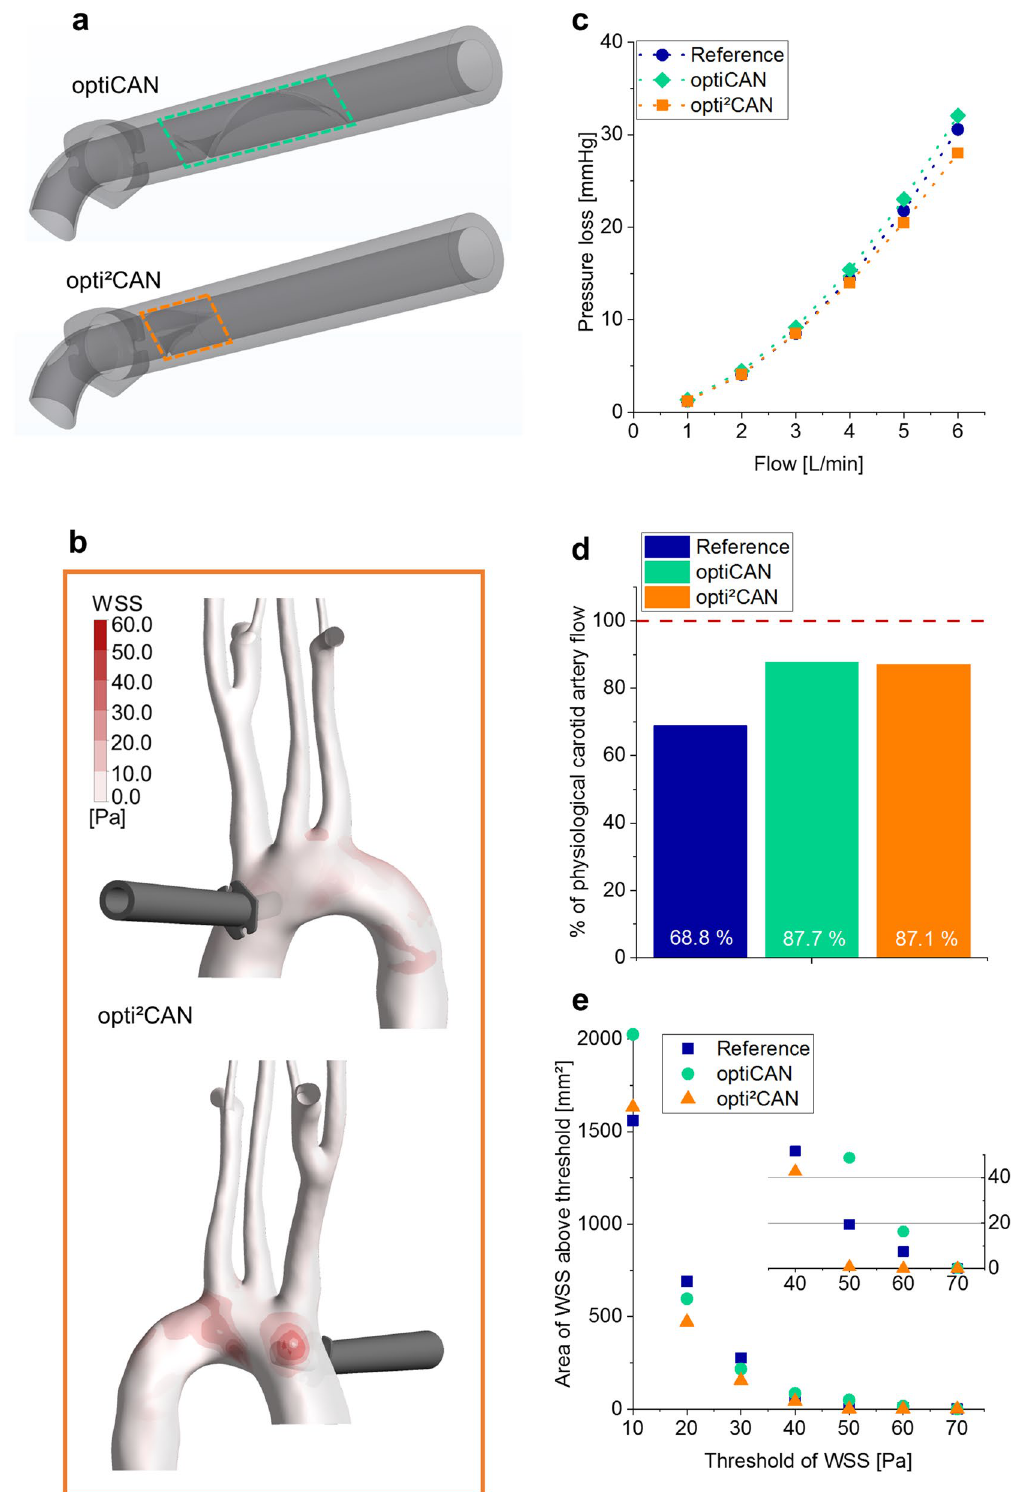
Figure 5. Results for further CFD-optimized design opti 2 CAN. ( a ) 3D models of the optiCAN and opti 2 CAN design. Different inner wall geometry is highlighted with dashed lines. ( b ) WSS on the intima of the aortic arch for opti 2 CAN during CPB. High WSS resembles high impact on the intima and can lead to detachment of plaque. ( c ) Pressure loss over cannula flow predicted from CFD simulations comparing reference, optiCAN and opti 2 CAN design. ( d ) Comparison of relative carotid artery flow for reference, optiCAN and opti 2 CAN design. Dashed line marks physiological level. ( e ) Accumulated area of WSS above the critical threshold versus the respective critical threshold of WSS for all three cannula designs. Inset shows a zoom for high thresholds of